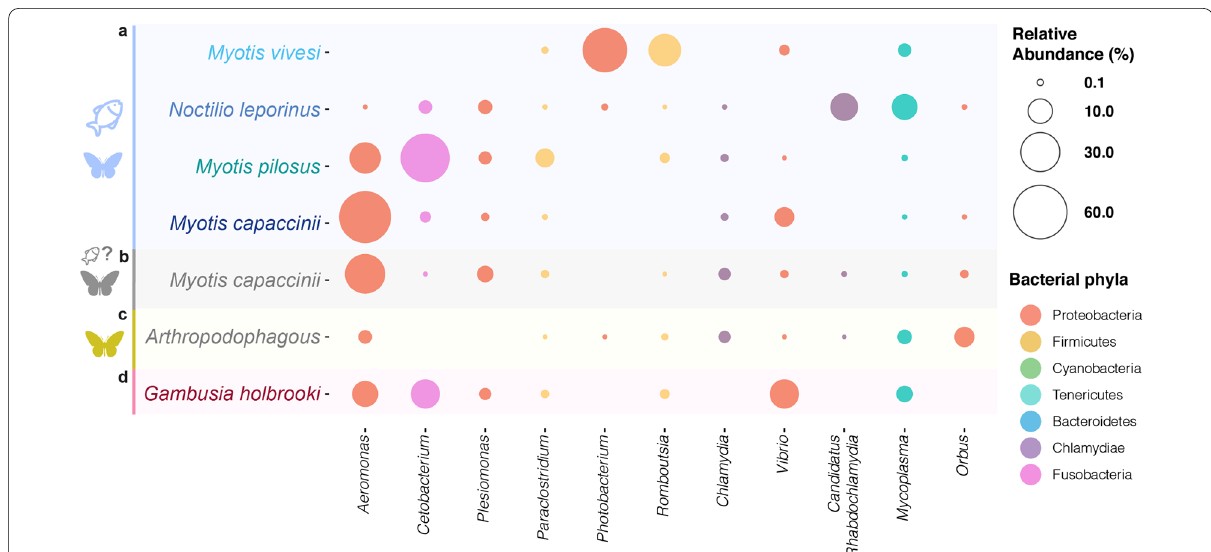
Fig. 4 Relative abundance of the most relevant bacteria enriched in piscivorous or arthropodophagous bats in a the four piscivorous bat species, b Myotis capaccinii colonies in which no piscivory has been recorded so far, c the eleven arthropodophagous bats analysed, and d the eastern mosquitofish ( G. holbrooki ) consumed by piscivorous M.